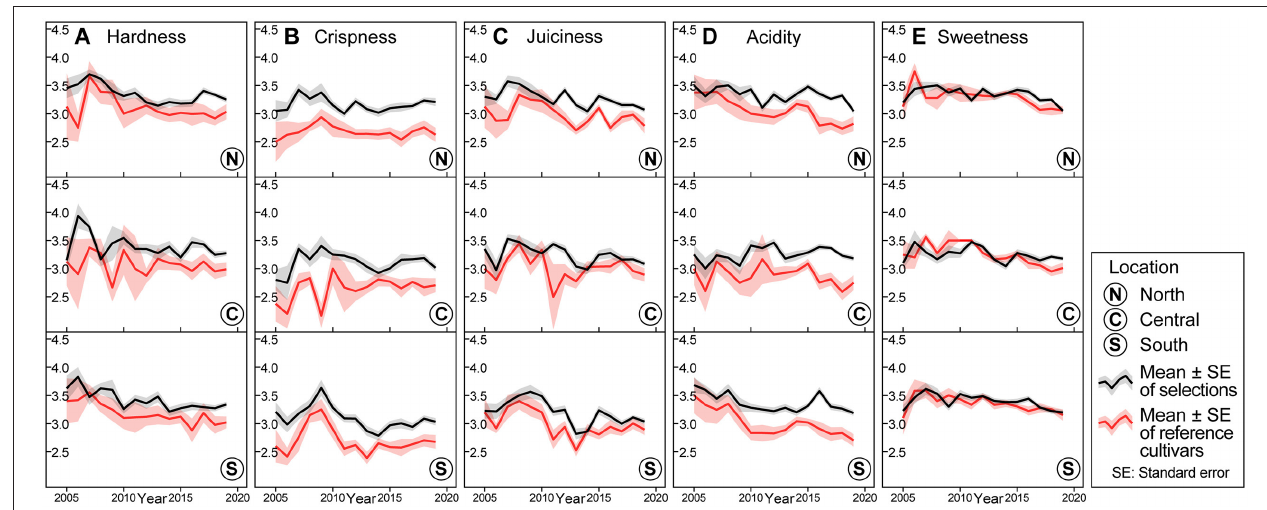
FIGURE 2 | Trends of sensory assessed fruit quality traits for Washington State University apple breeding program for phase two selections and reference cultivars from 2005 to 2019. Means (as lines) and standard errors (as shades) of selections (in black), and cultivars (in red) for (A) hardness (B) crispness, (C) juiciness, (D) acidity, and (E)